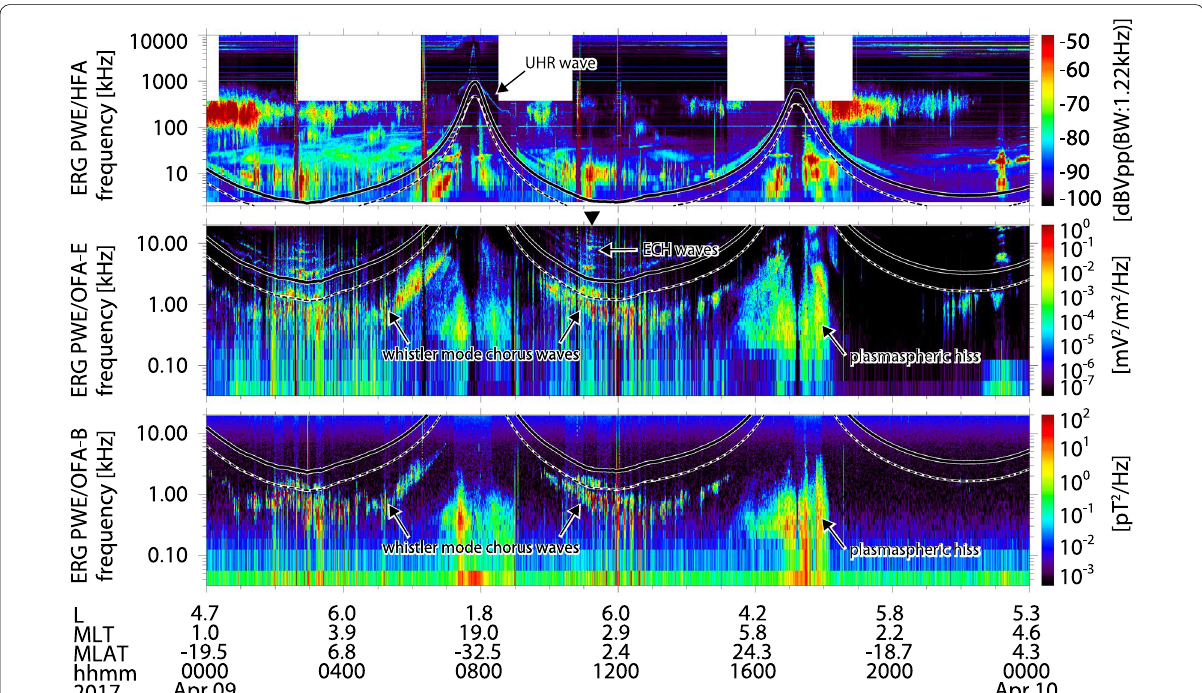
Fig. 16 (Top) Electric field power spectra as measured by the HFA on April 09, 2017. (Middle and bottom) Electric and magnetic field power spectra during the day as measured by the OFA-SPEC on April 09,